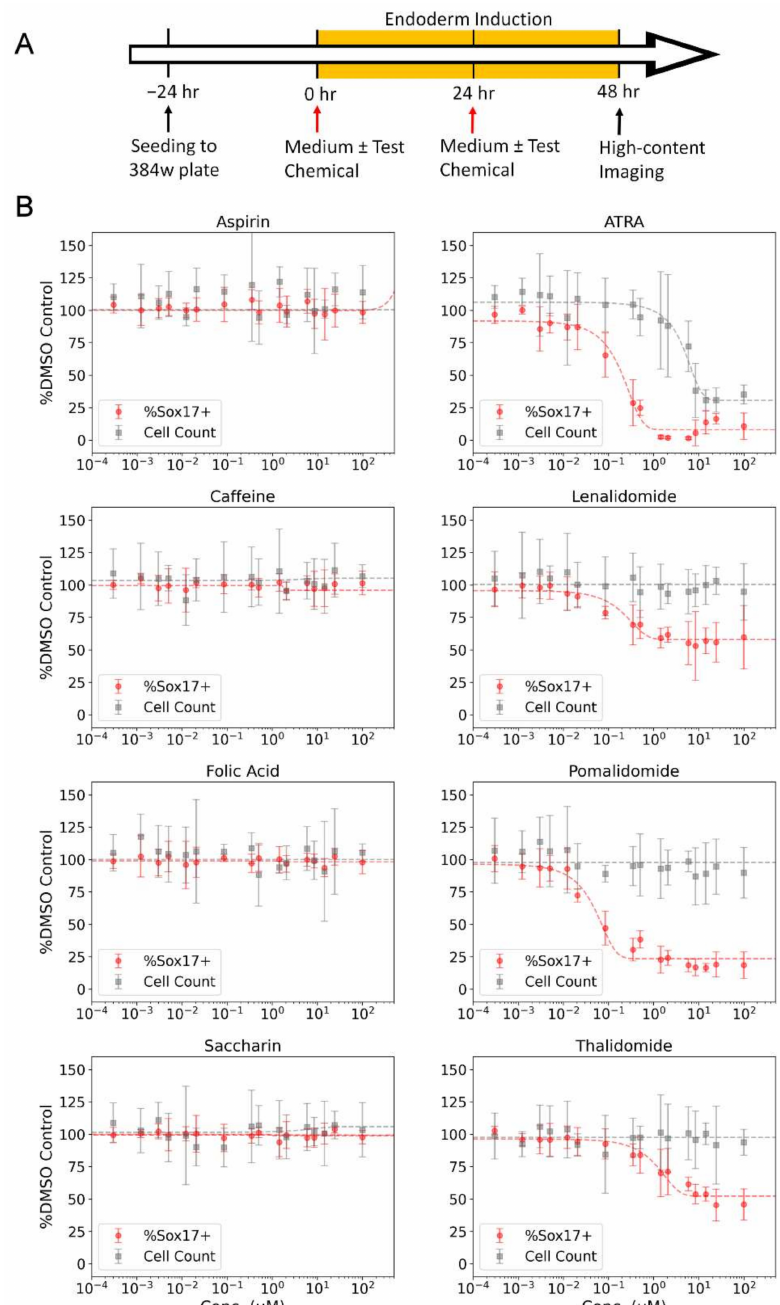
Figure 3. Reference chemical testing in the DevTox GLR-Endo assay. ( A ) Timeline for DevTox GLR- Endo assay. RUES2-GLR cells were exposed to reference chemicals for 48 h during directed endoderm differentiation. ( B ) Negative reference chemicals (aspirin, caffeine, folic acid, and saccharin) are on the left column, positive reference chemicals (all-trans retinoic acid (ATRA), lenalidomide, pomalidomide, thalidomide) are on the right column. Gray points display average cells counted per well (cell count) and red points display the average percentage of SOX17-positive cells per well (%SOX17+). Dashed lines represent regression curve fits. Error bars-2*bmad; ( n =